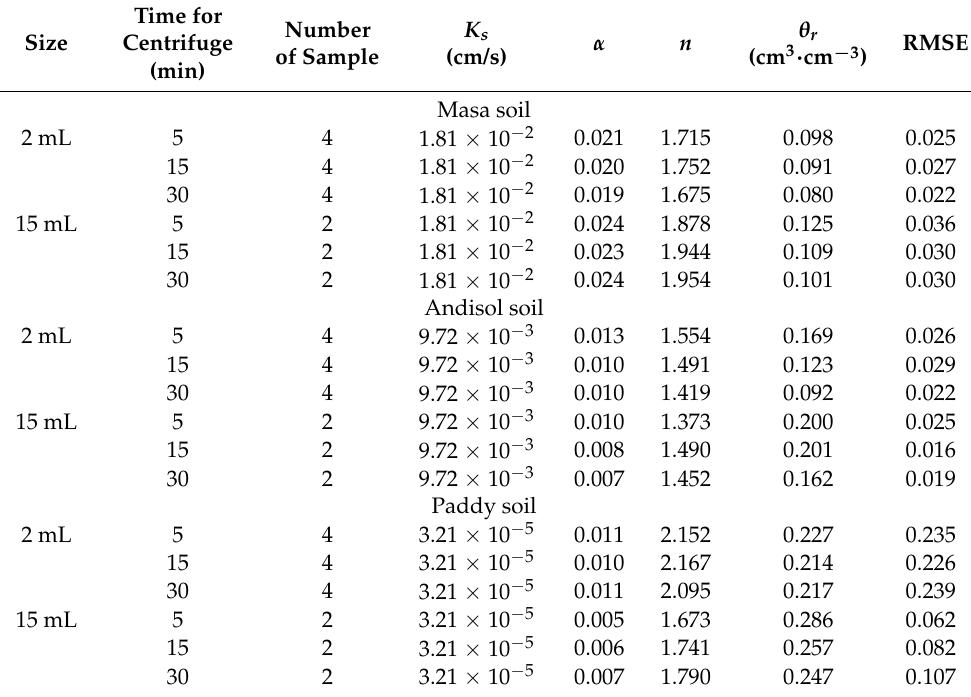
Table 3. Optimization results (fixed K s